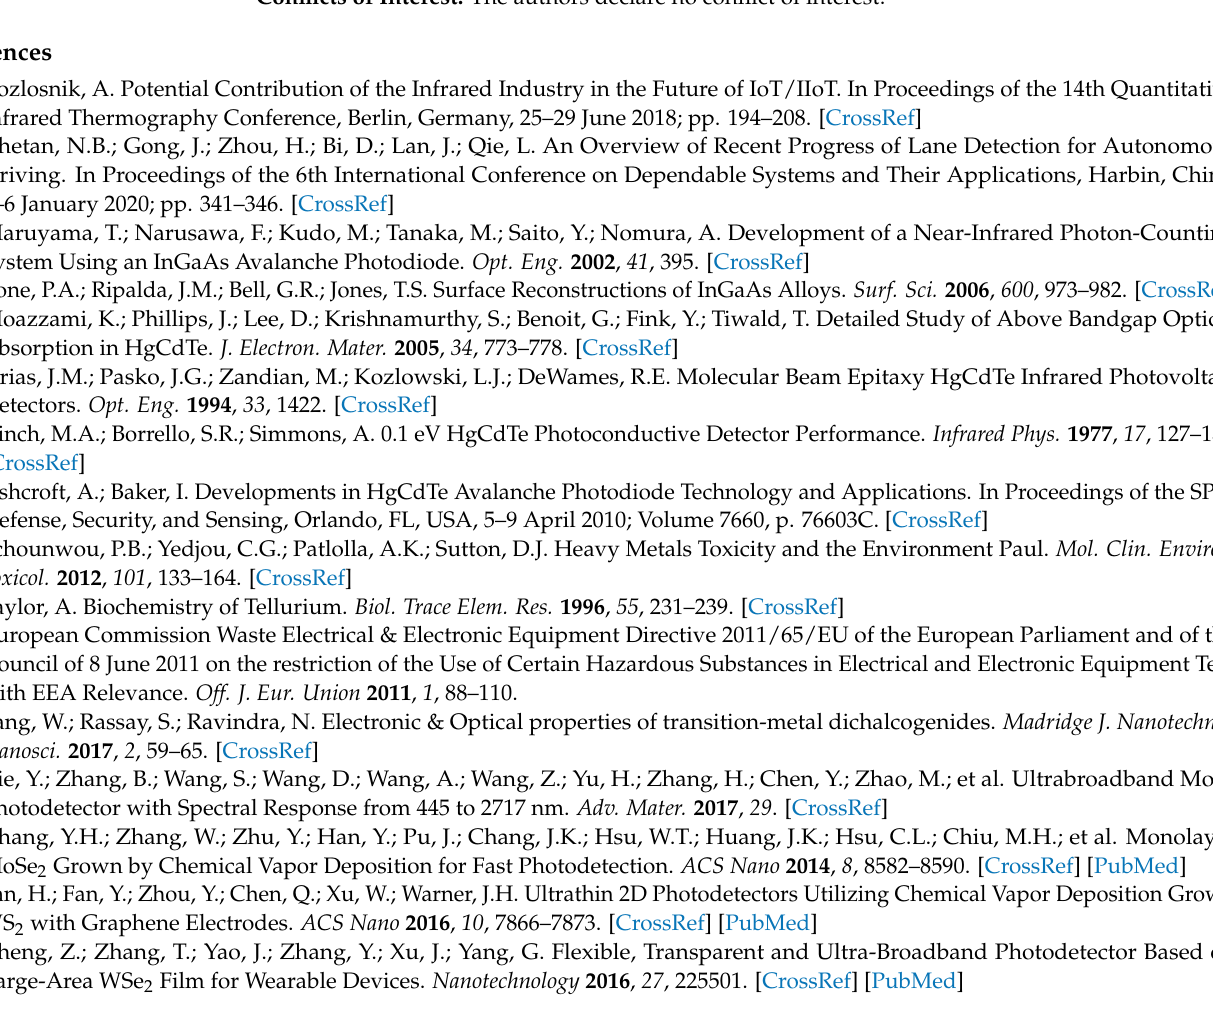
Figure S2: Photograph of Au nanorod solutions of various concentrations. Figure S3: Dimensional drawing of the interdigitated comb shadow mask. Figure S4: ON/OFF cyclic performance test of 5 nM Au nanorod/2D PtSe 2 at 940 nm. Figure S5: Photocurrent comparison of 3% masked Au nanorod/2D PtSe 2 and bare 2D PtSe 2 at 940